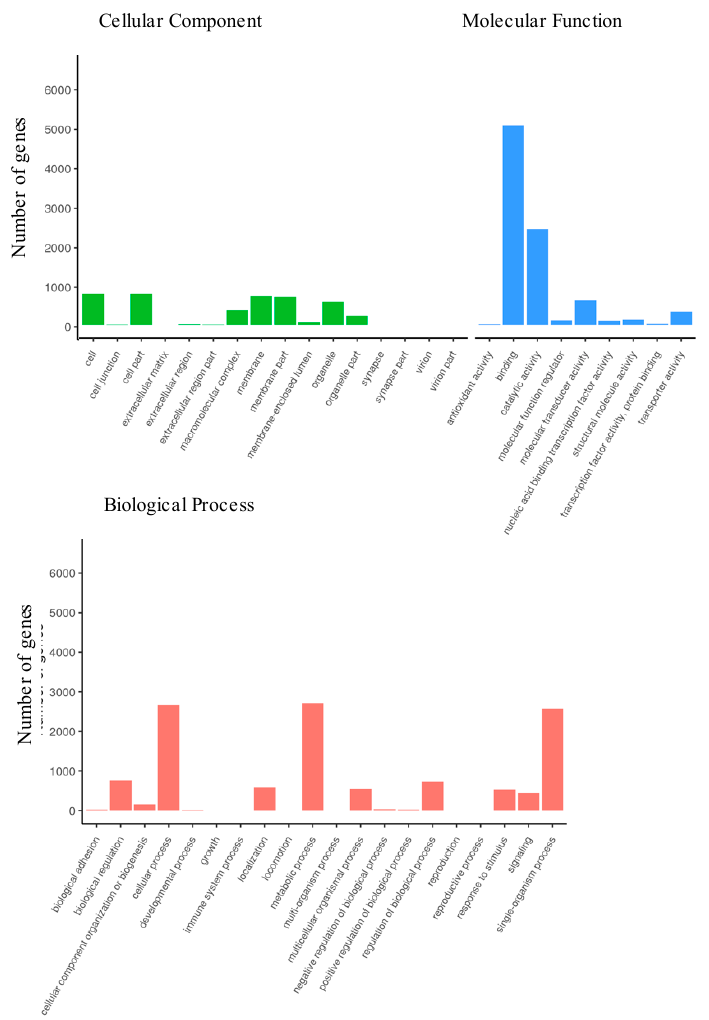
Figure 5. Gene ontology (GO) histograms showing GO enrichment of differentially expressed genes (DEGs) between infection status treatment groups, divided into categories: biological processes, cel- lular components, and molecular function. Green bars represent cellular components, blue represent molecular functions, and red represent biological processes.